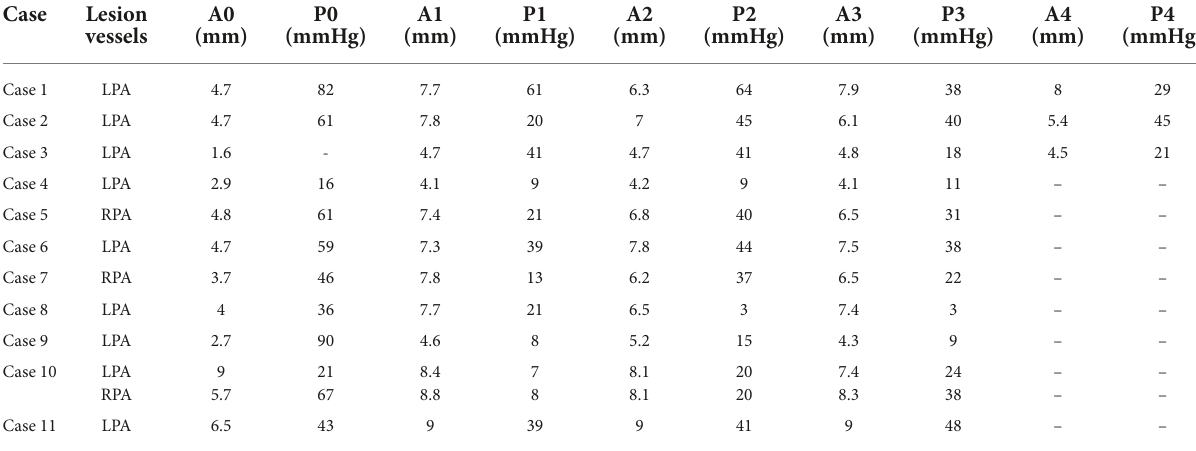
TABLE 4 Echocardiographic vessels parameters in 11